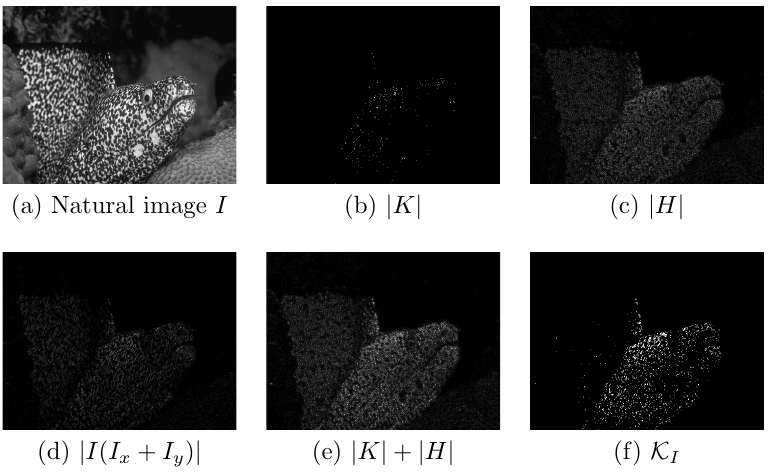
Figure 1. The different components used to find our